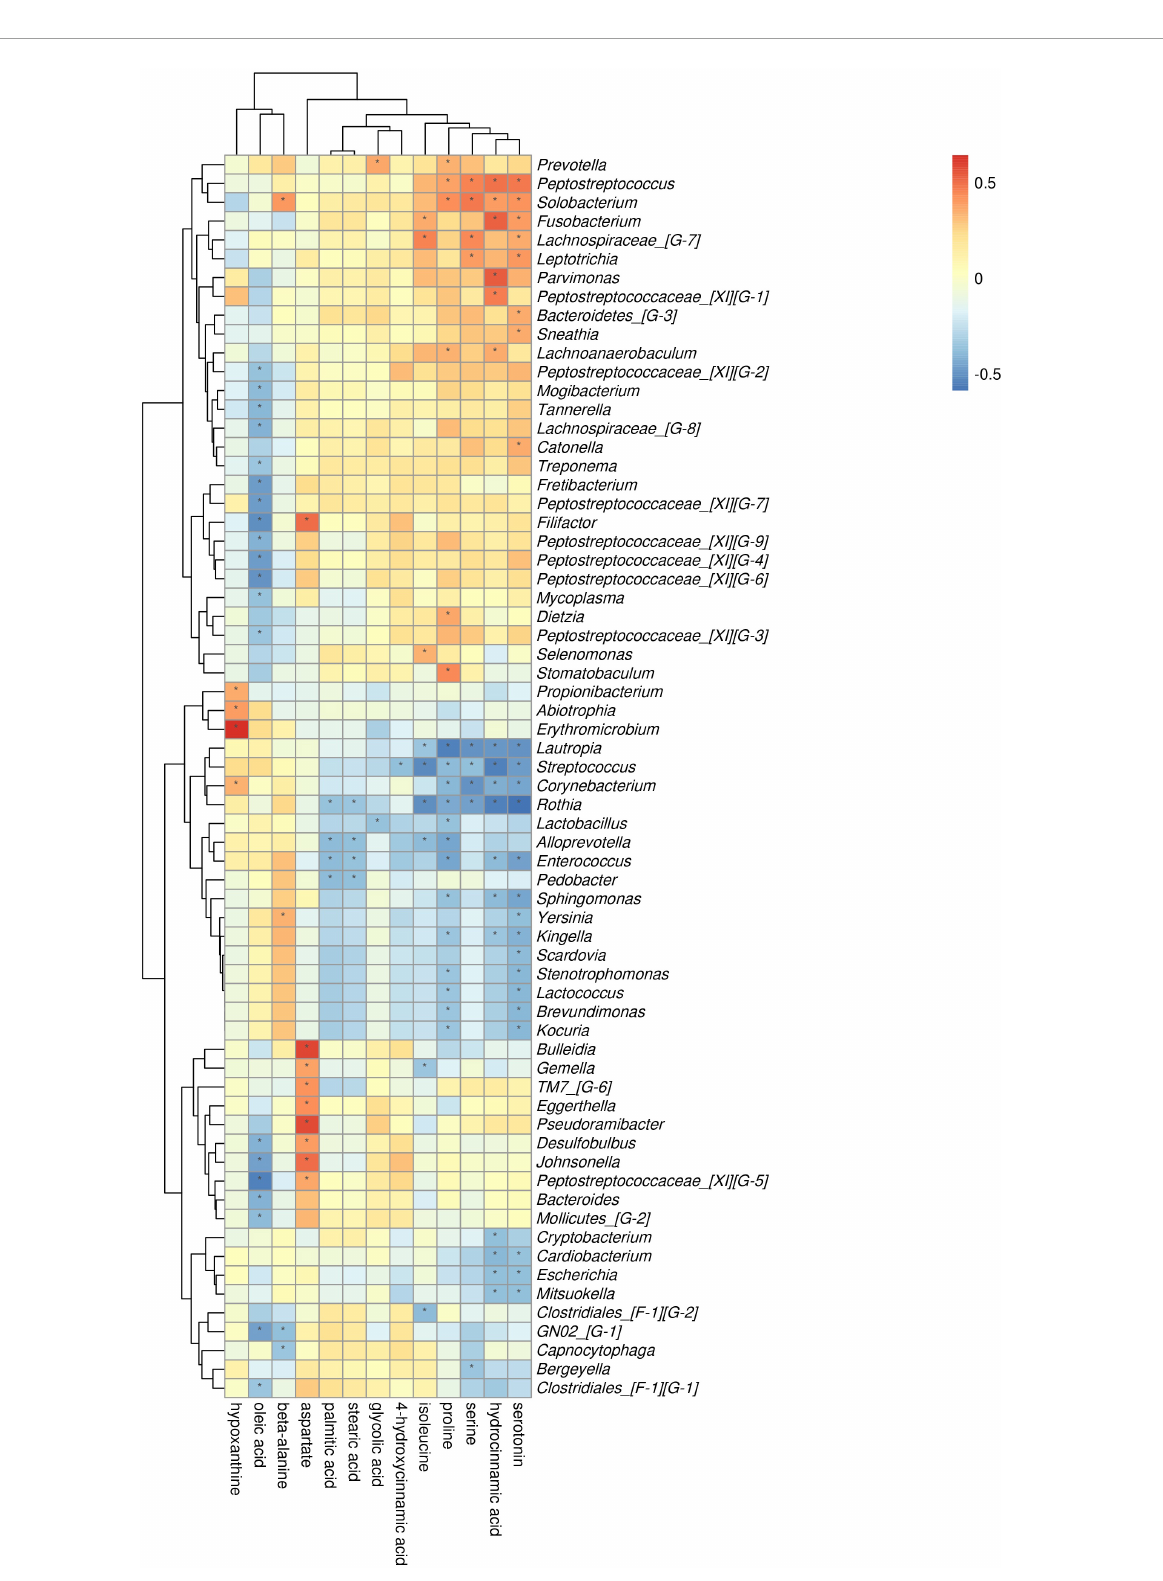
FIGURE9 Association of microbial genera with differential metabolites in AgP and PH. Color intensity represents the magnitude of correlation. Red, positive correlations; blue, negative correlations. *Significant correlation between the genus and metabolite ( p < 0.05).